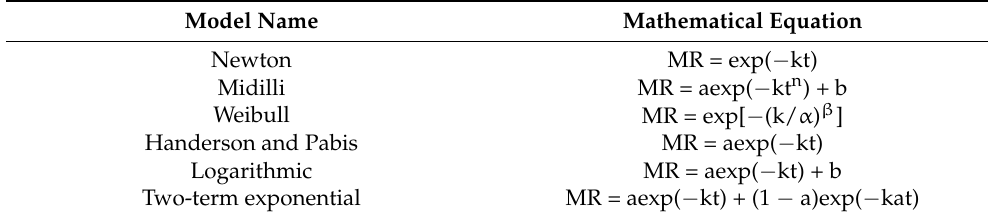
Table 1. Drying models used for drying kinetics of Angelica sinensis